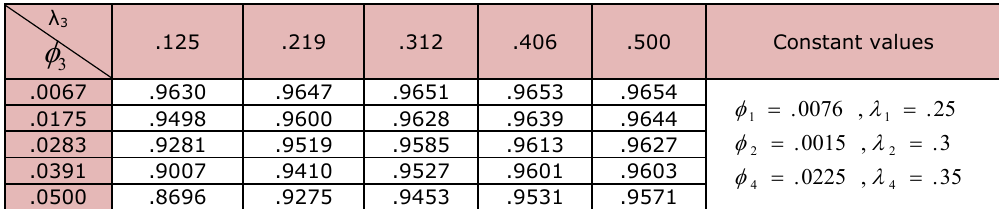
Table 3. “Availability matrix of FD fans subsystem of Flue gas and air